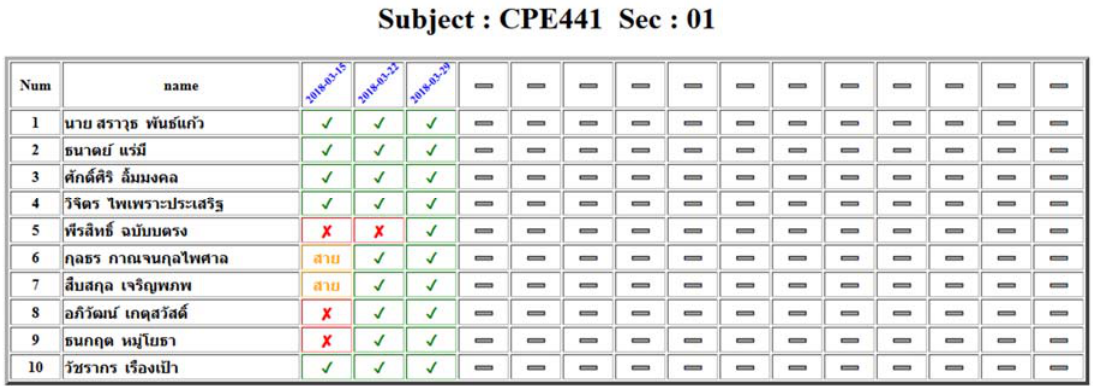
Figure 14. Status of student attendance in class.